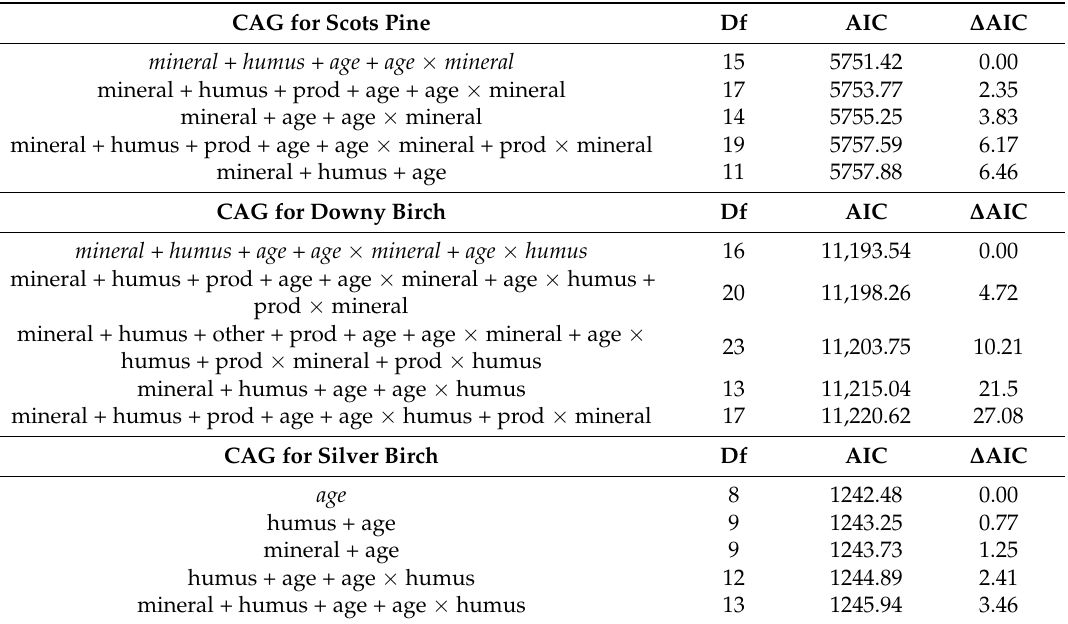
Table 6. Results from model selection on current annual growth of Scots pine, downy birch, and silver birch seedlings, measured as a log (ln) transformed length of top shoot. The table shows the five models with lowest AIC from 38 candidate models for pine CAG, 31 candidate models for downy birch CAG, and 15 candidate models for silver birch CAG. Model parameters are presented with corresponding degrees of freedom, AIC value, ∆ AIC, and AIC weights. Models are ranked from lowest to highest AIC. The models which were considered the most optimal are written in italics. Abbreviated variable names are: mineral = proportion of exposed mineral soil, humus = proportion of exposed humus, year = year of scarification, other = proportion of other cover, prod = forest productivity index, age = age of tree